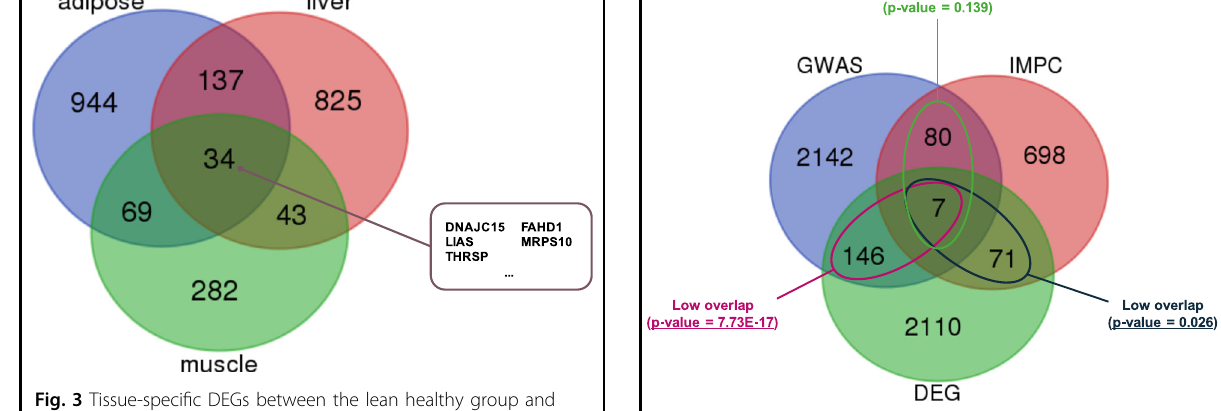
overlaps. Hypergeometric p -values for lower overlapping amount are given for each